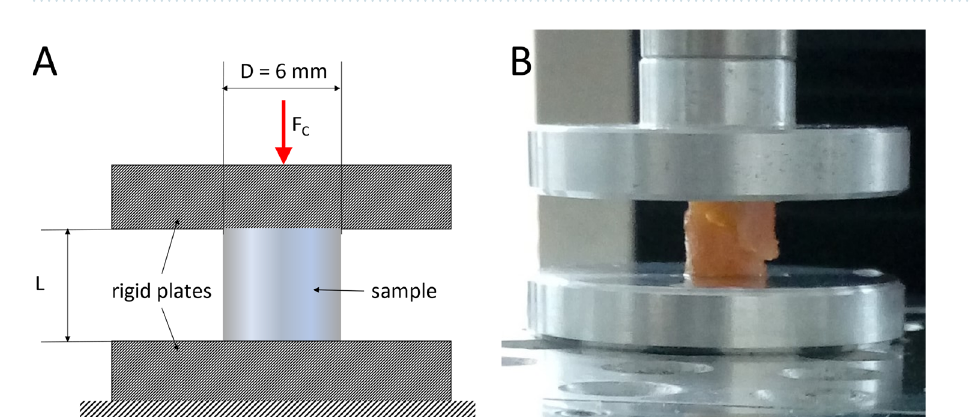
Figure 1. Sample harvesting of costal cartilage. ( A ) Schematic of the numbering of the individual rib location. ( B ) Schematic of the samples for the unconfined compression test and the indentation test in mediolateral and dorsoventral direction.